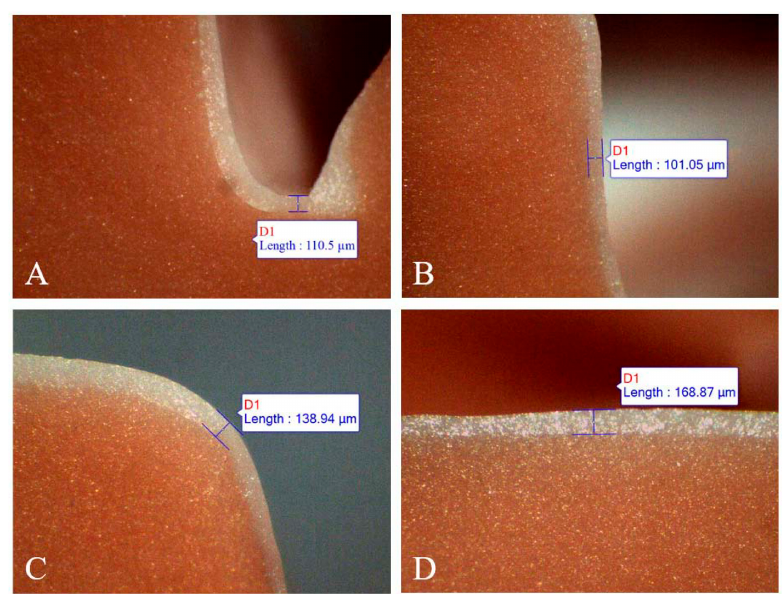
Figure 6. The blue lines represent the measurement discrepancies between the crown and the abutment tooth by the analysis software. A, marginal gap, B, axial gap, C, gap of the cusp tip, D, occlusal gap.